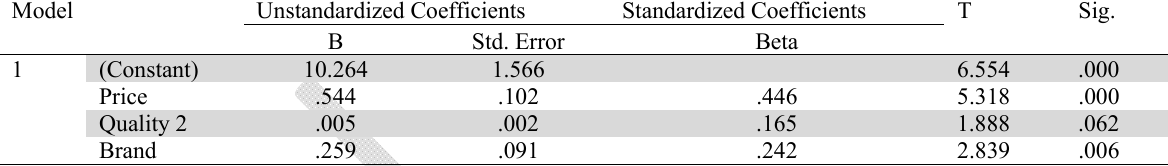
Model 6 Multiple Linear Regression Test Results (Coefficients a ) Model Unstandardized Coefficients Standardized Coefficients